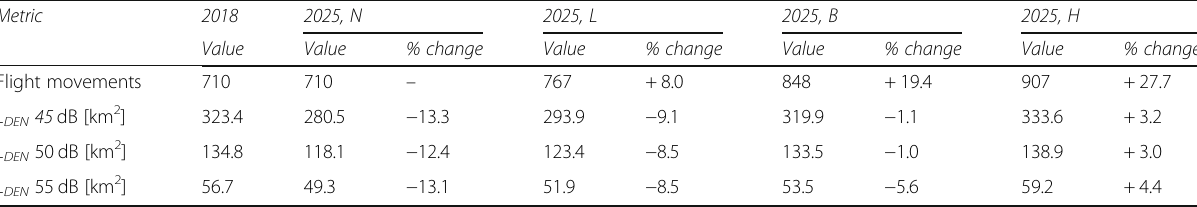
Table 5 L DEN at Vienna in 2018 and 2025 under four assumptions (N = no traffic increase, L = low, B = baseline, H = high) Metric Flight